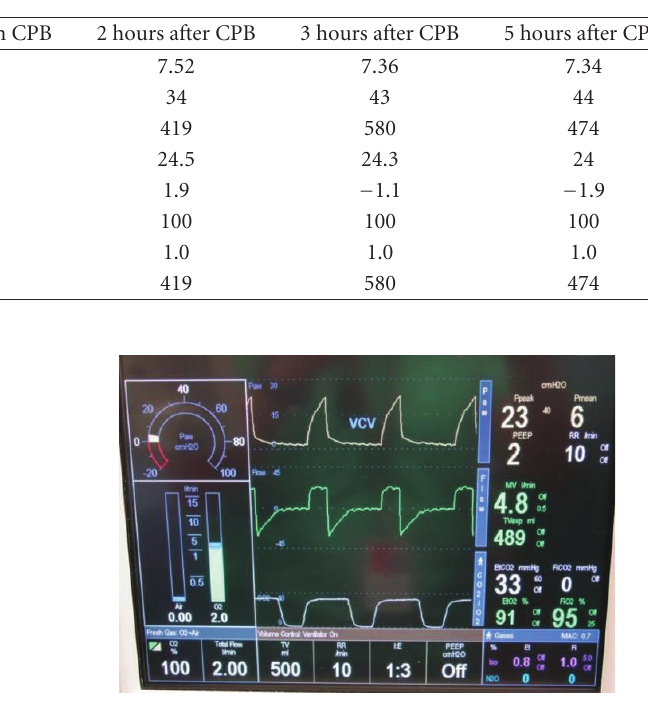
Figure 3: ETCO 2 after